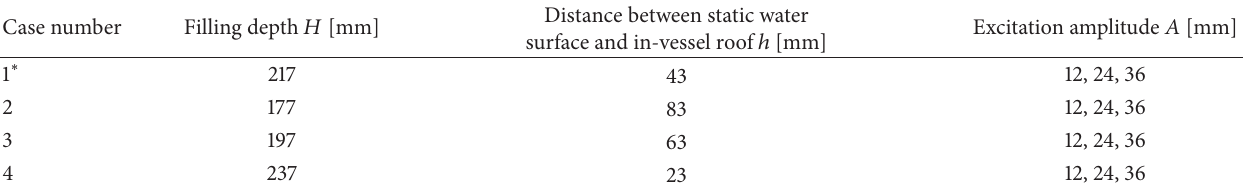
Table 2: Experiment sequences.